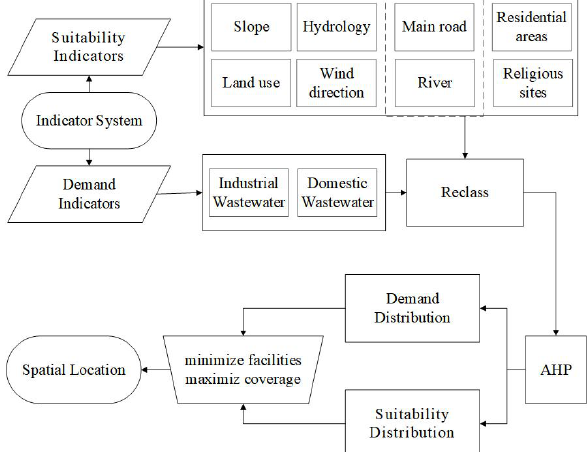
Figure1. The main process.